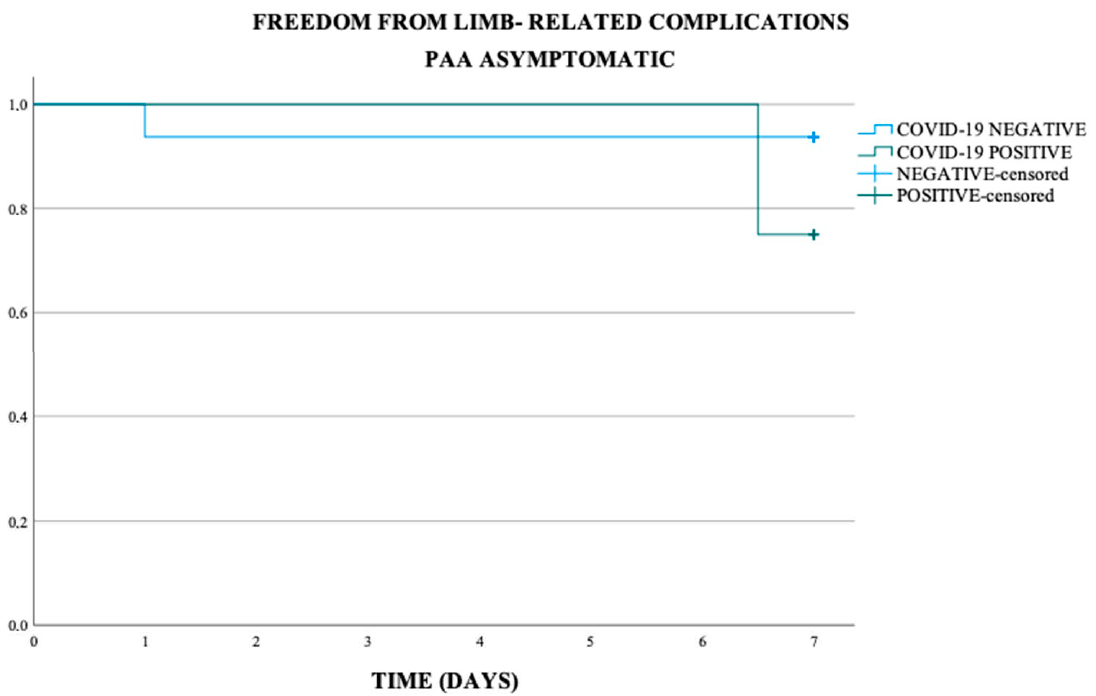
Scheme 1. Freedom from limb-related complications ( p -value < 0.001).